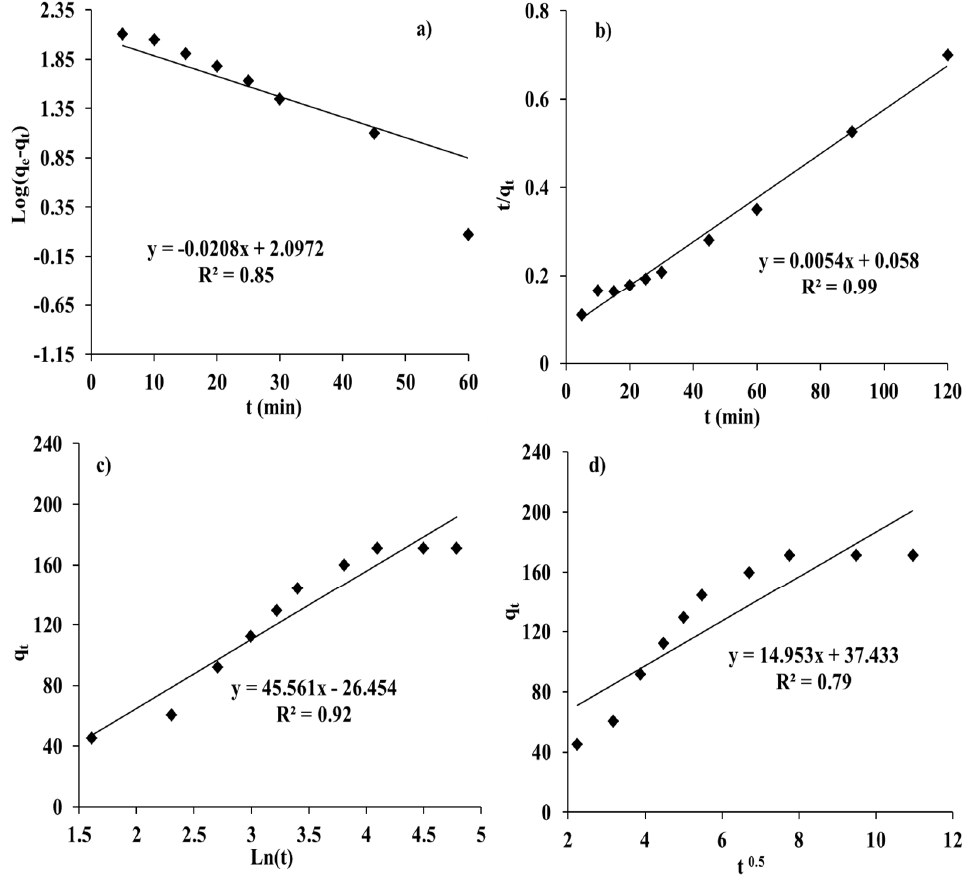
Figure 2. Kinetic models for Y(III) adsorbed on the AHIBC adsorbent ( a ) pseudo-first-order, ( b ) pseudo-second-order, ( c ) Elovich kinetic, and ( d ) intraparticle diffusion.